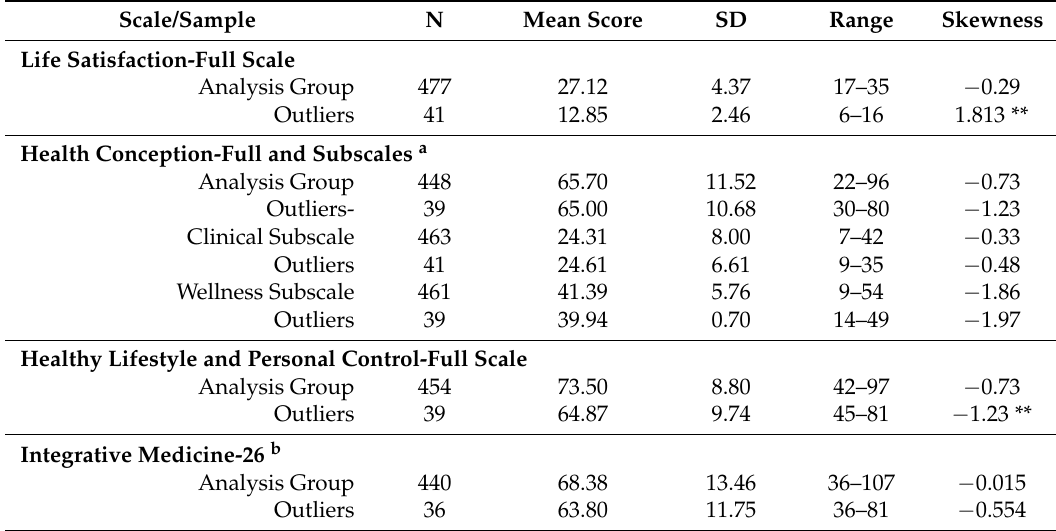
Figure 2. Model of Life Satisfaction of Registered Dietitian Nutritionists. Note: Standardized regression weights shown; Integrative Practice = IM-26, Lifestyle = HPLCQ, Wellness Philosophy = LHCS, and SWLS = Satisfaction with Life. * p < 0.05, ** p < 0.001. Table 5. Comparison of outliers to analysis group.